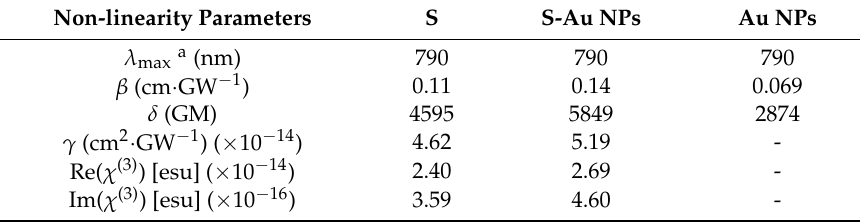
a Best nonlinear absorption wavelength. Figure 8. The synthesis route of S-Au NPs ( 51 ). Table 4. Open- and closed-aperture Z-scan measurement data for the third-order nonlinearity parameters of S, S-Au NPs ( 51 ) in DMF with 10 − 3 M concentration. Non-linearity Parameters